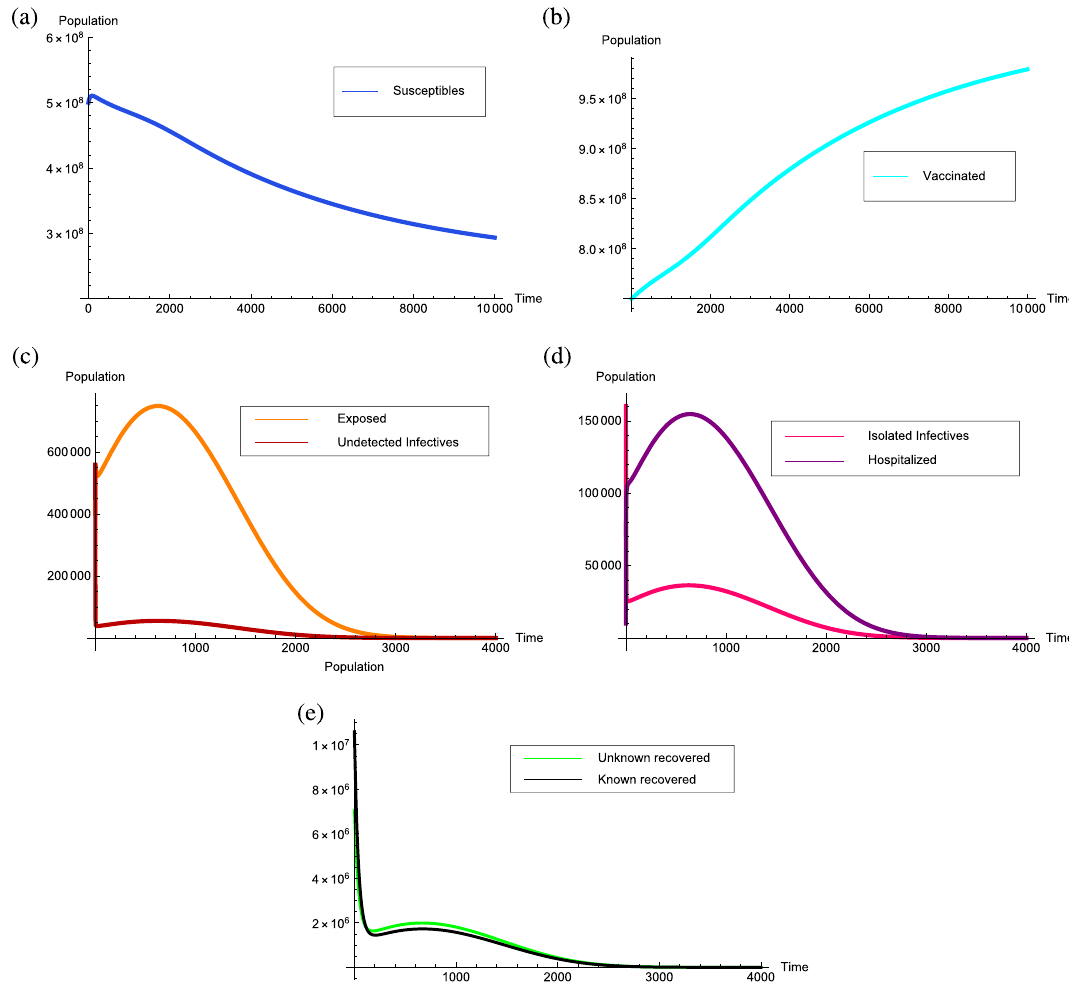
0 = ( 2.51256 × 10 8 , 0, 1.0308 × 10 9 , 0, 0, 0, 0, 0 )